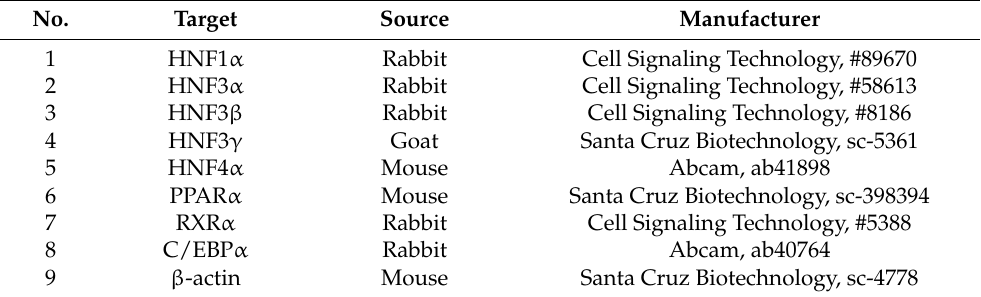
Table 3. Primary antibodies for Western